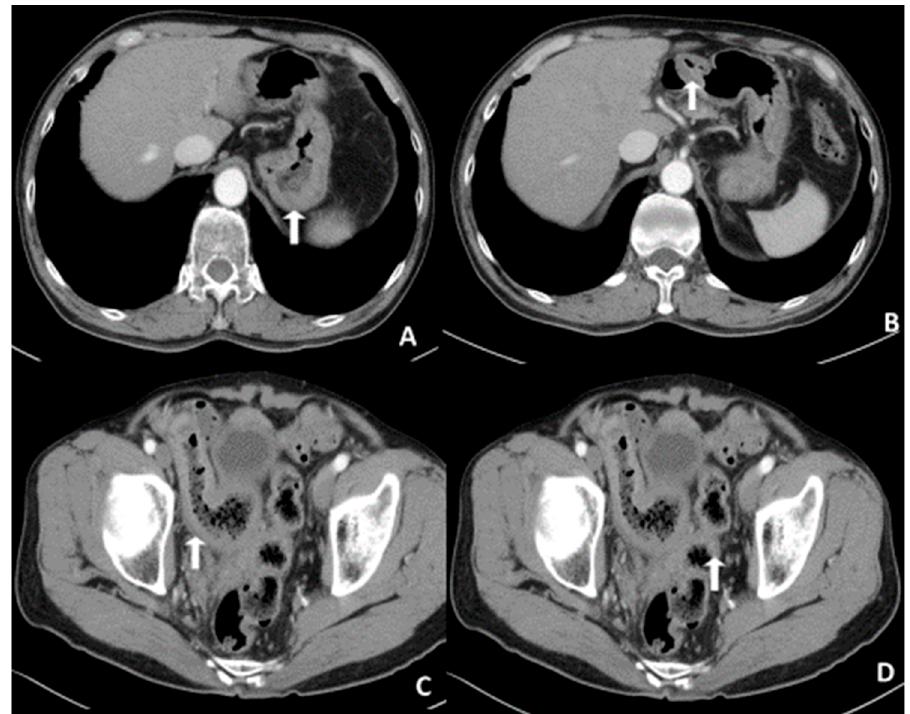
Figure 2. The abdominal CT scan revealed MALToma in the stomach ( A ), duodenum ( B ), terminal ileum ( C ), and sigmoid ( D ).